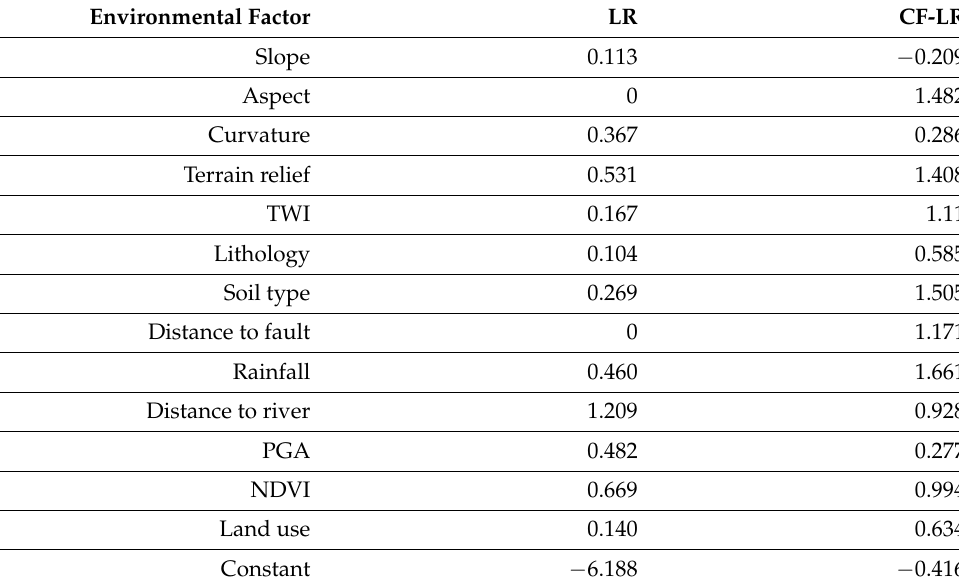
Table 7. Coefficients and constant terms for LR and